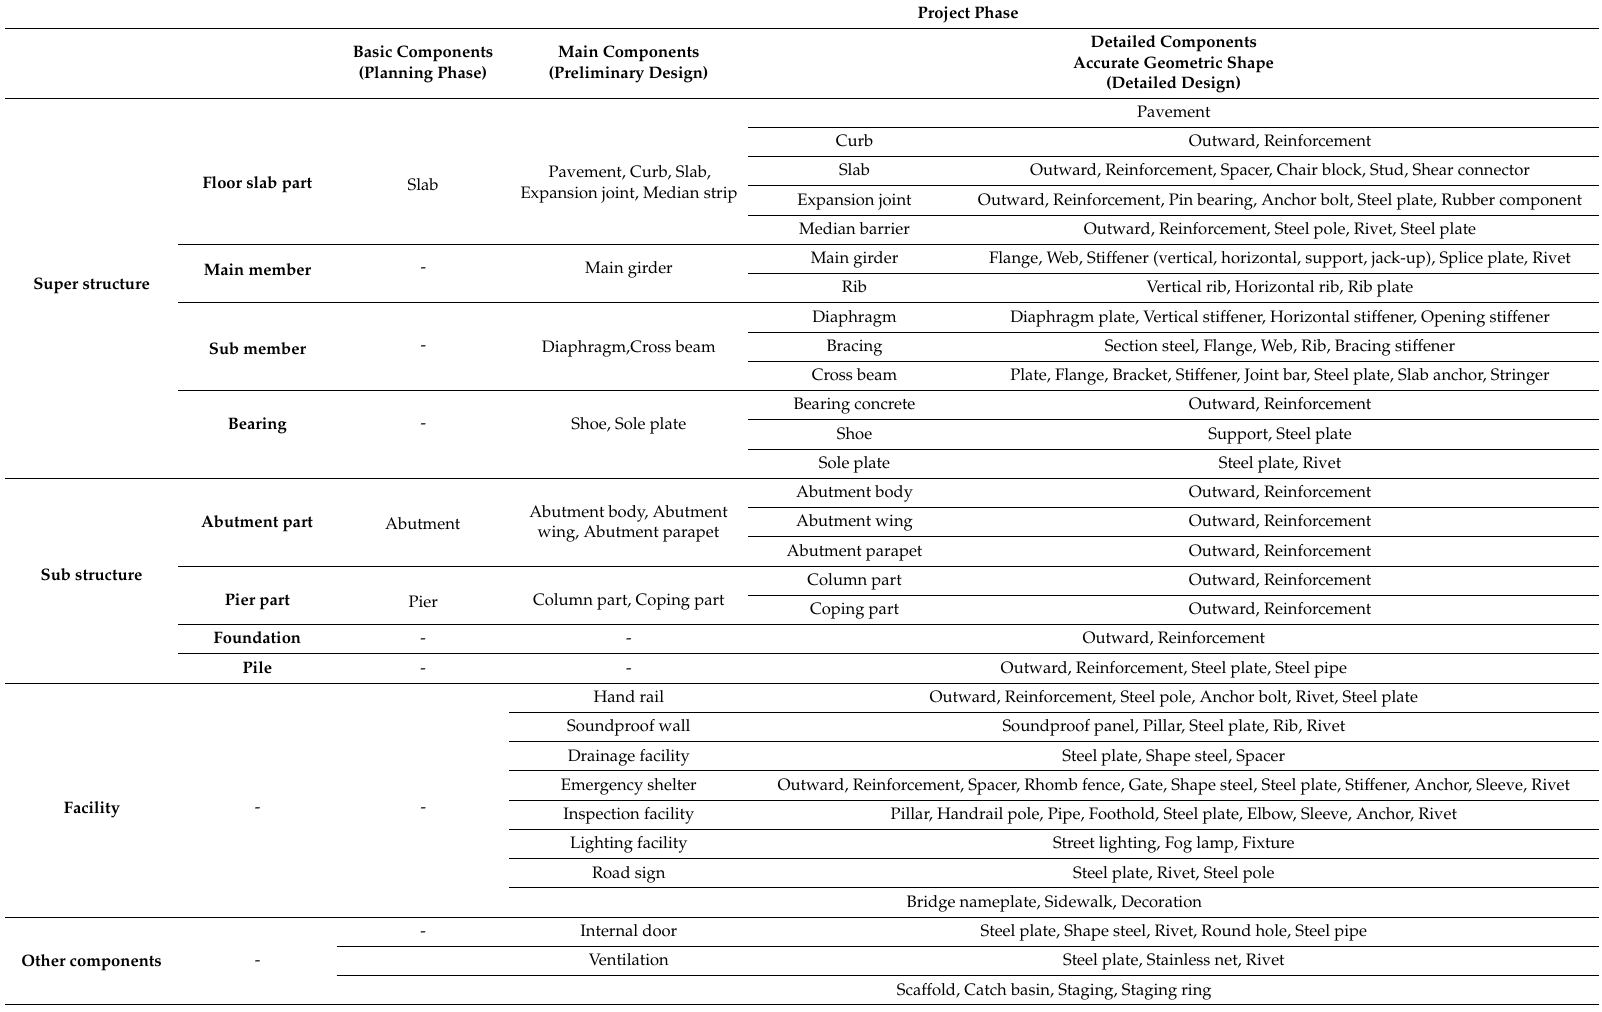
Table 2. The breakdown of steel box girder bridge in planning and design